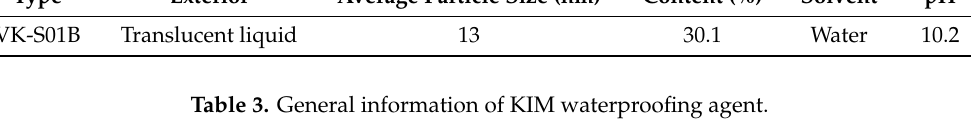
Table 2. Performance characteristics of nano-SiO 2.